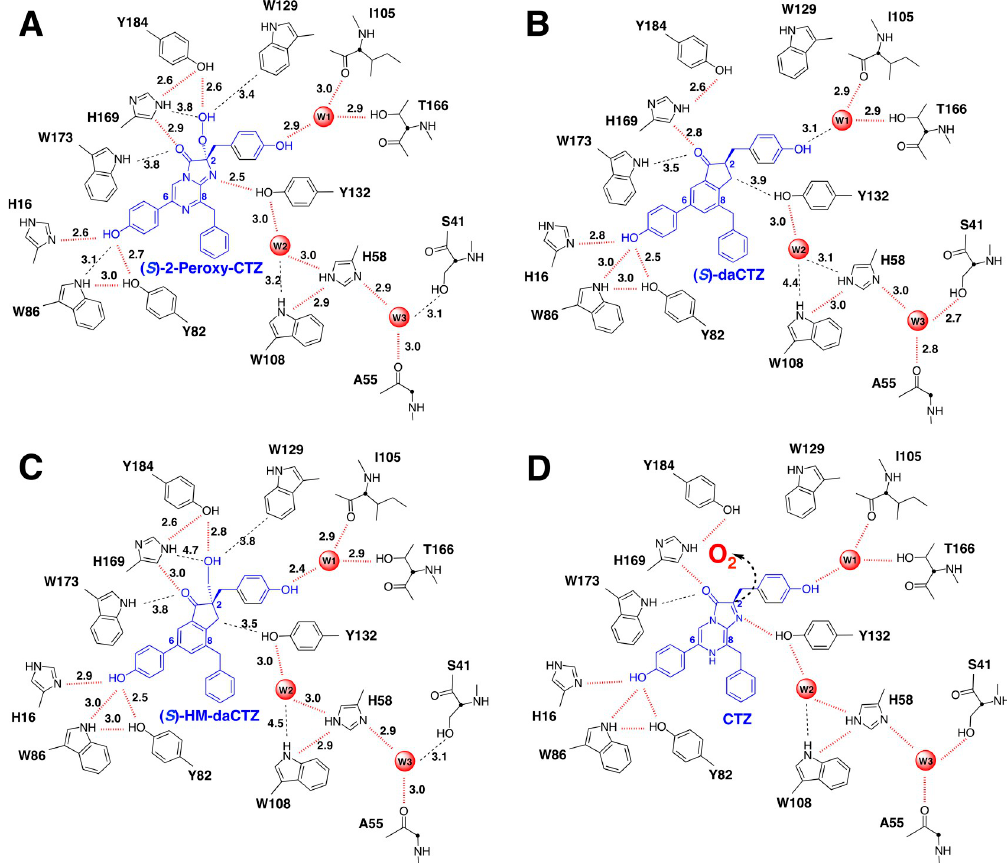
Fig 9. Comparison of the hydrogen-bonding networks in the ( S )-2-peroxycoelenterazine binding cavity among native aequorin (A), the apoAequorin/( S )-daCTZ complex (B), the apoAequorin/( S )-HM-daCTZ complex (C), and the predicted binding of coelenterazine in apoAequorin (D).